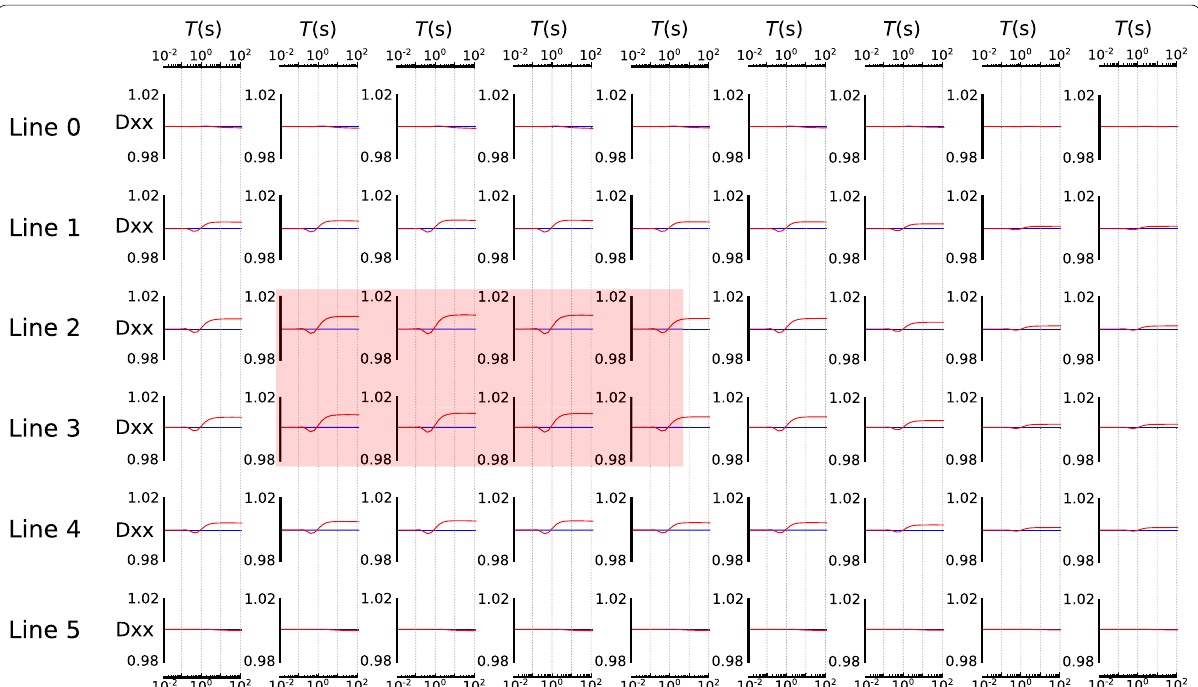
Fig. 3 Synthetic transfer functions ( D xx ) comparing base (orange dashed box in Fig. 2) and measured (purple dashed box in Fig. 2) sites for Lines 1–6. The x -axis is the period in seconds. The blue transfer functions represent the baseline model, and red transfer functions result from the introduction of the 1 (cid:31) m conductive body at 3.6 km depth (represented by the red shaded rectangle). Note that only the real components of the transfer functions are plotted